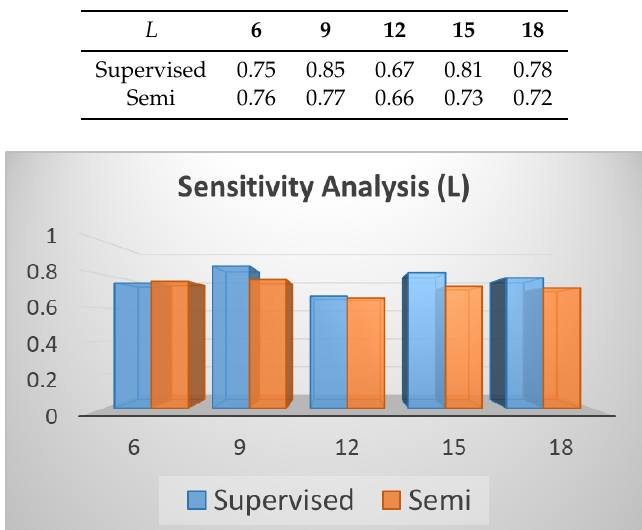
Figure 11. Sensitivity Analysis